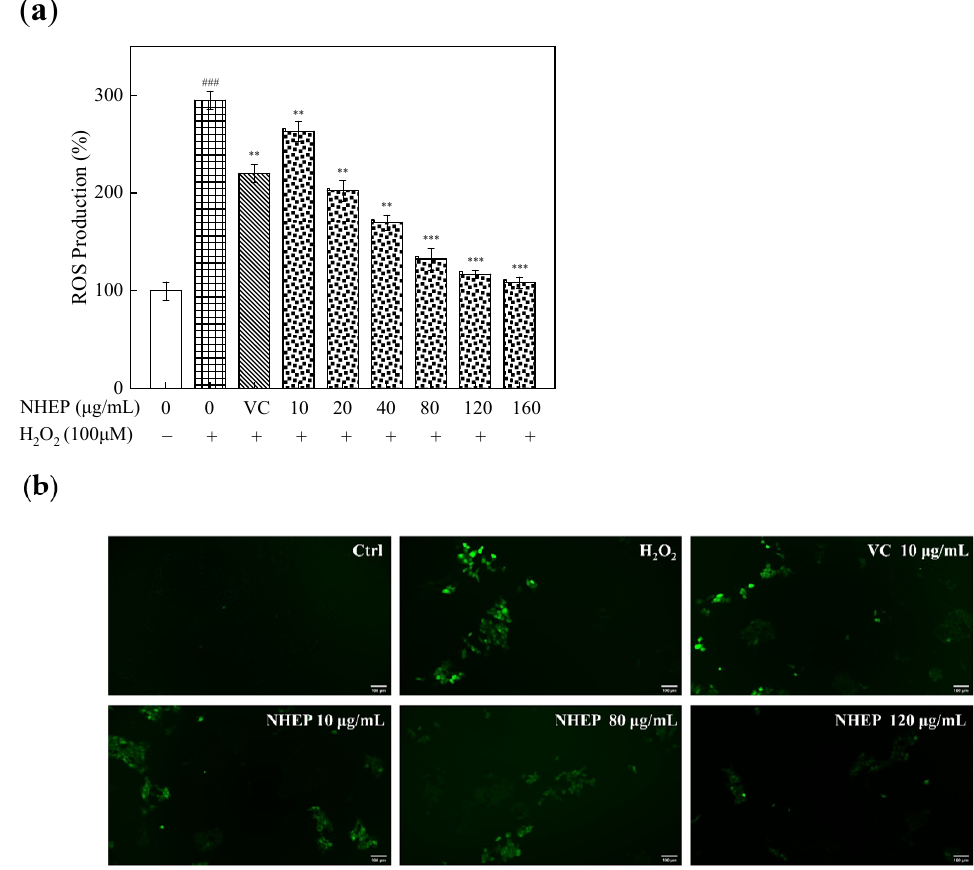
Figure 10. Effects of NHEP on the ROS level of HaCaT cells with stimulation of H 2 O 2 : ( a ) ROS production, ( b ) fluorescence intensity by detected the DCFH-DA. VC stands for Vitamin C, and the concentration is 10 μ g/mL (scale bar is 100 μ m). Significance: ### p < 0.001 compared with the control group. ** p < 0.01, *** p < 0.001 compared with the H 2 O 2 stimulation group. The data are shown as the mean ± S.D. ( n = 5).